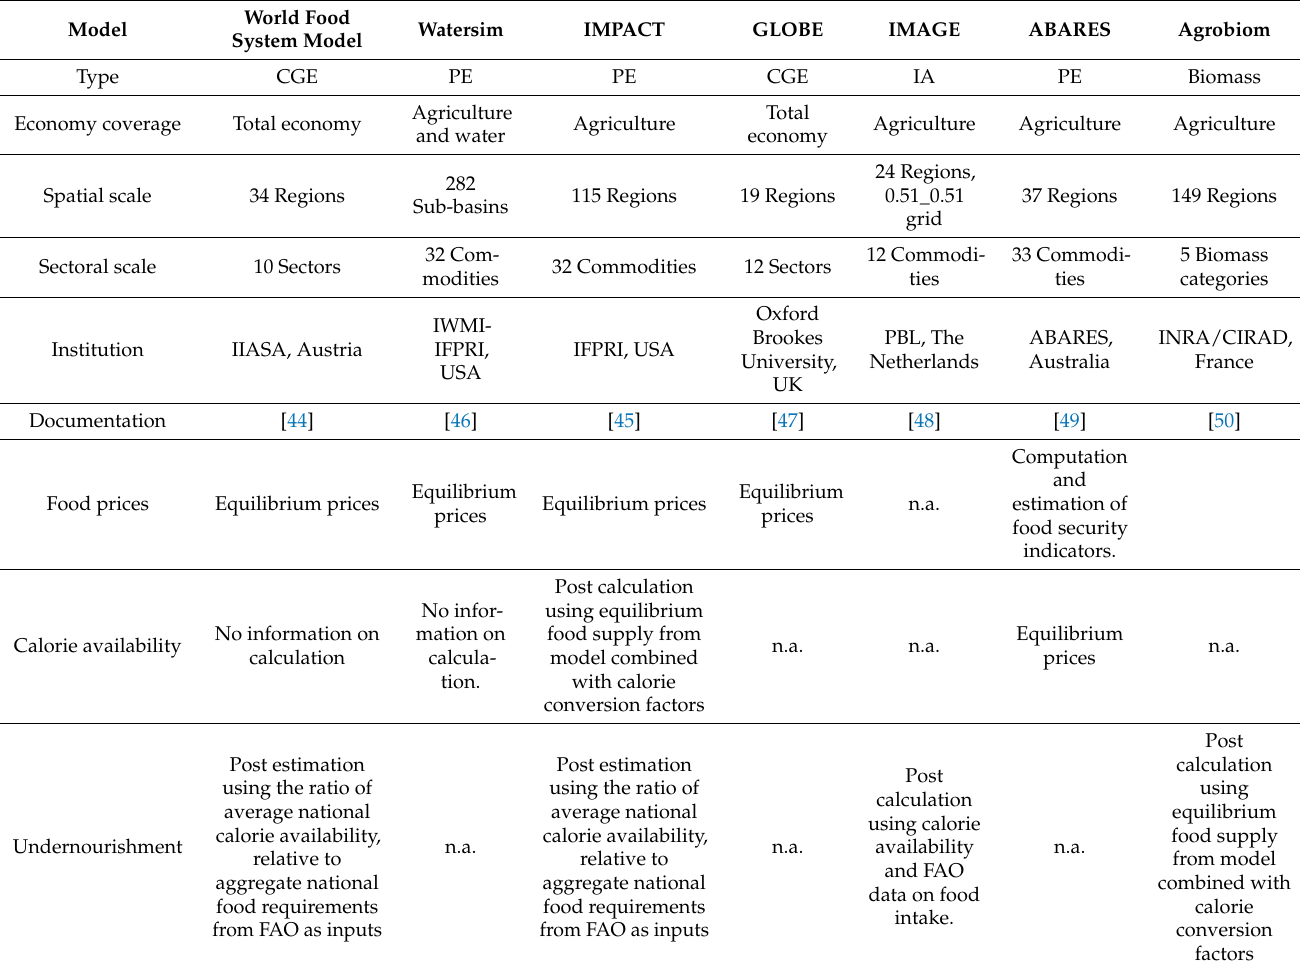
Table 1. Typical models used in the global food security setup and appraisal